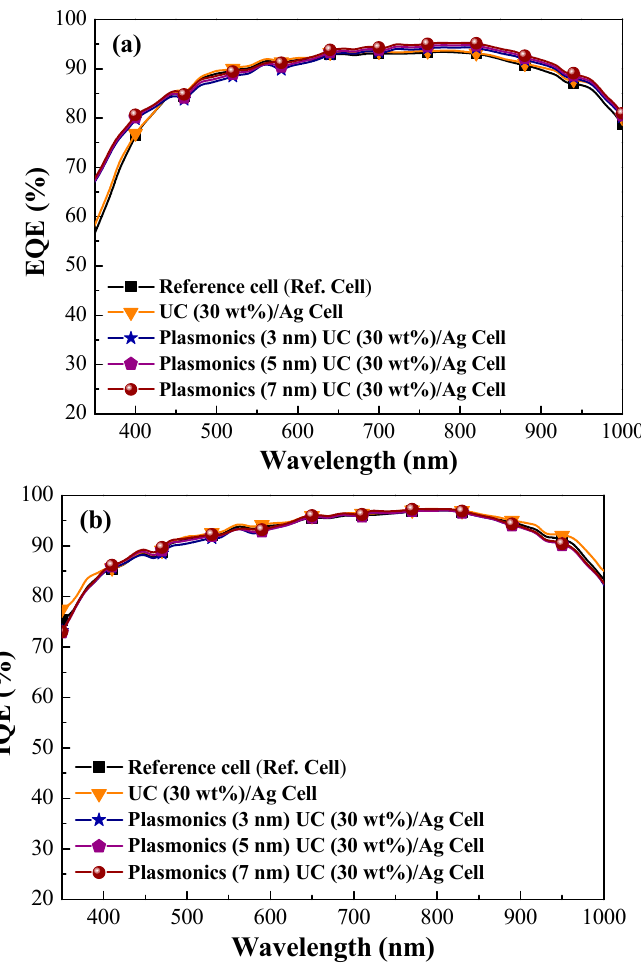
Figure 14. ( a ) EQE response and ( b ) internal quantum efficiency (IQE) response of reference cell, UC (30 wt%) / Ag cell, and plasmonic UC (30 wt%) / Ag cell with In NPs (3 nm, 5 nm, 7 nm).